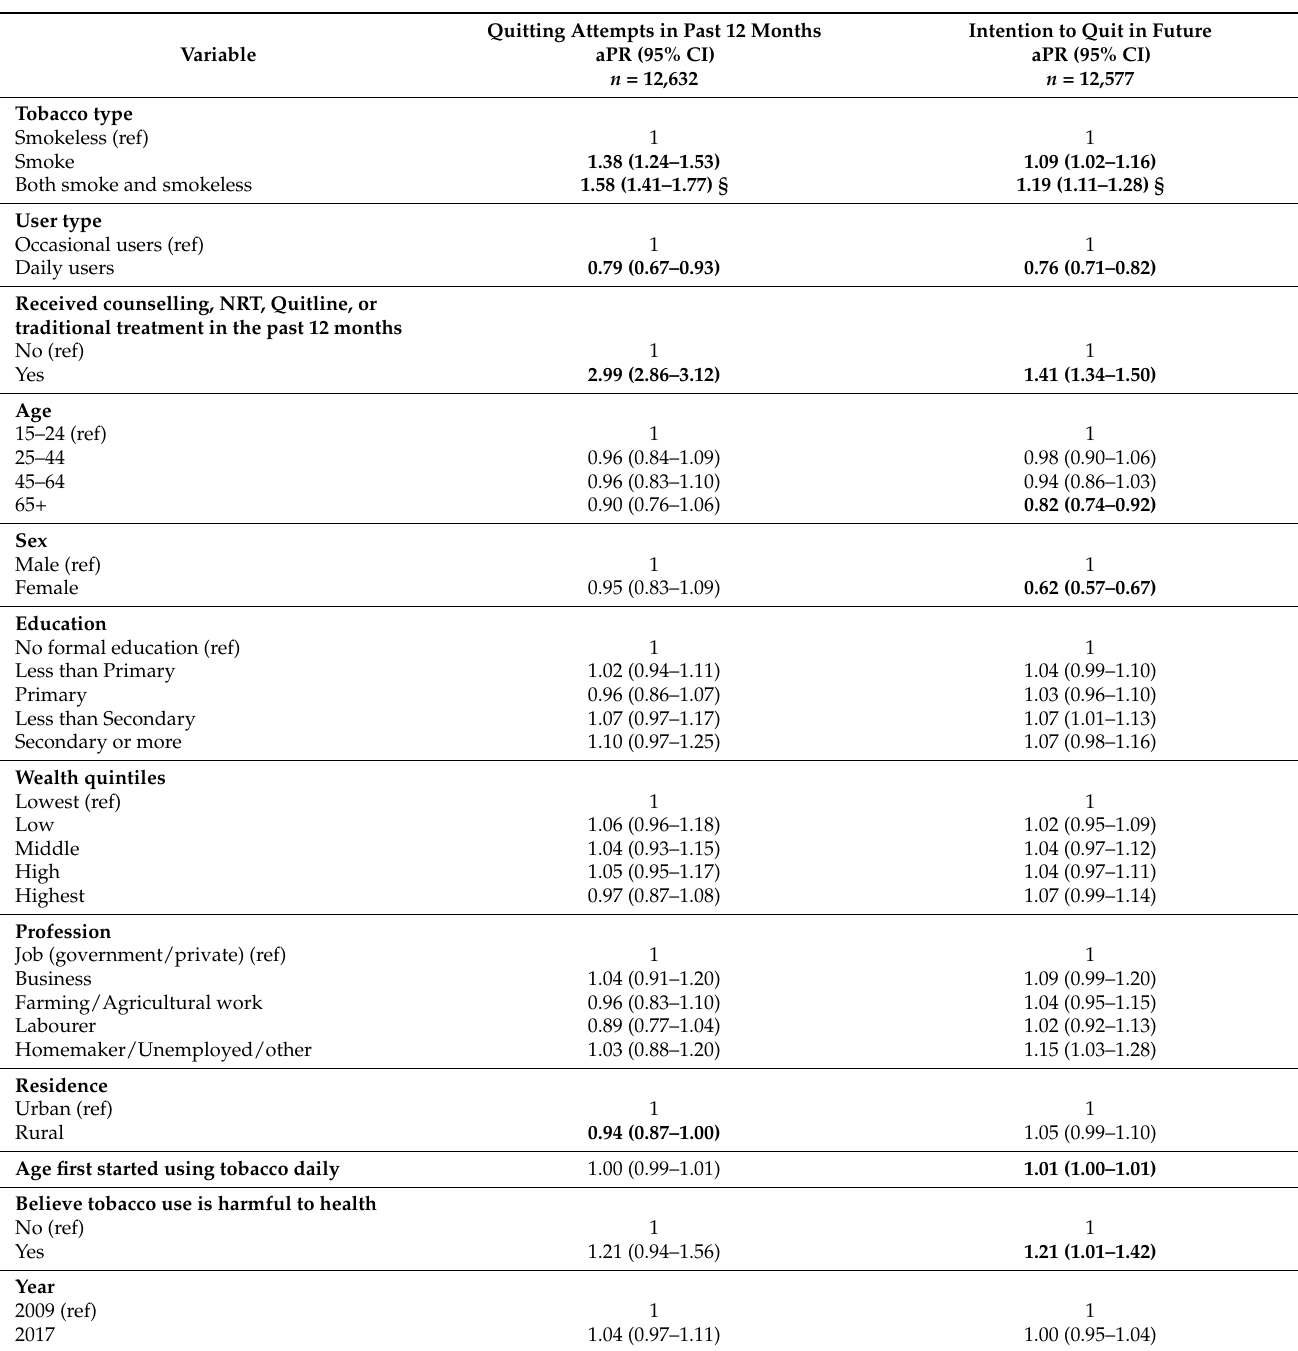
Table 2. Multivariable Poisson regression (with robust variance) examining the associations between smoke and/or smokeless tobacco use and quitting attempts in the 12 months before the survey and intention to quit in the